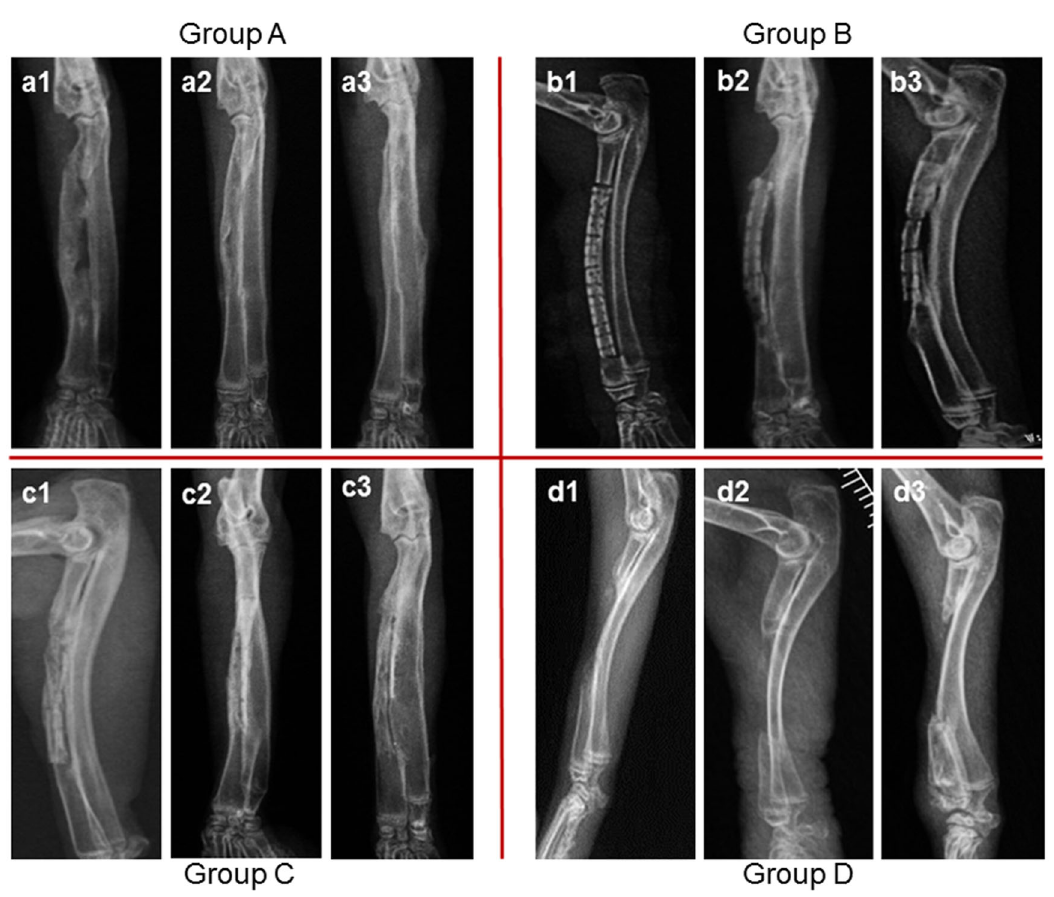
Fig. 5 Radiological view of bone defect repair in Group A at 4 weeks ( a1 ), 8 weeks ( a2 ) and 12 weeks ( a3 ); in Group B at 4 weeks ( b1 ), 8 weeks ( b2 ) and 12 weeks ( b3 ); in Group C at 4 weeks ( c1 ), 8 weeks